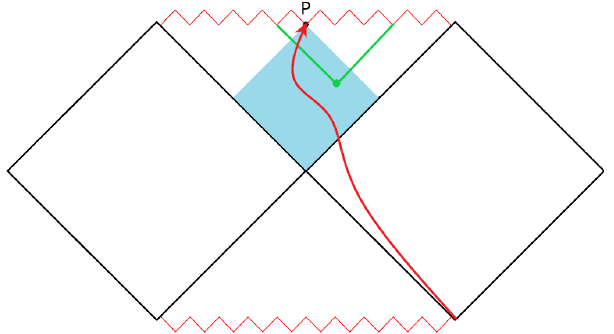
Figure 4. The blue region is the causal diamond connecting between the horizon bifurcation and the point where an infalling observer (with a trajectory marked by a red line) hits the singularity. The infalling observer encounters every IFS produced in the blue region. The folds of such an IFS are marked by the green